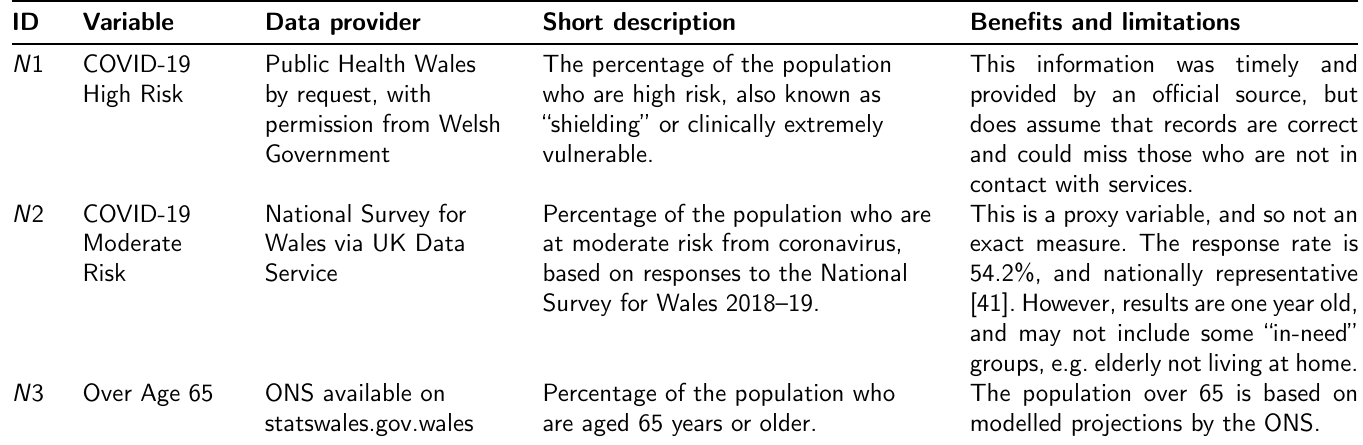
Table 2: Summary description of variables included in the transmission risk